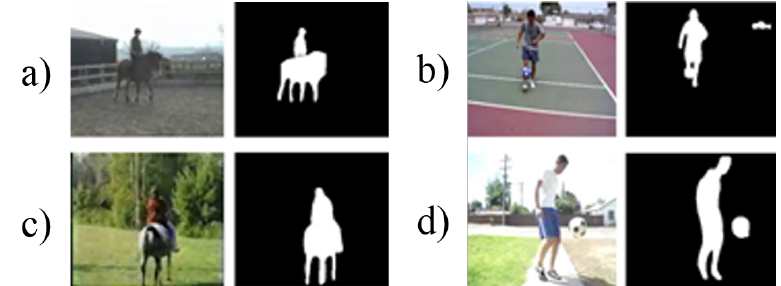
Figure 3. Example of an RGB image with corresponding pairwise inputs. ( a ) “HorseRiding”. ( b ) “SoccerJugglings”. ( c ) “HorseRiding”. ( d )